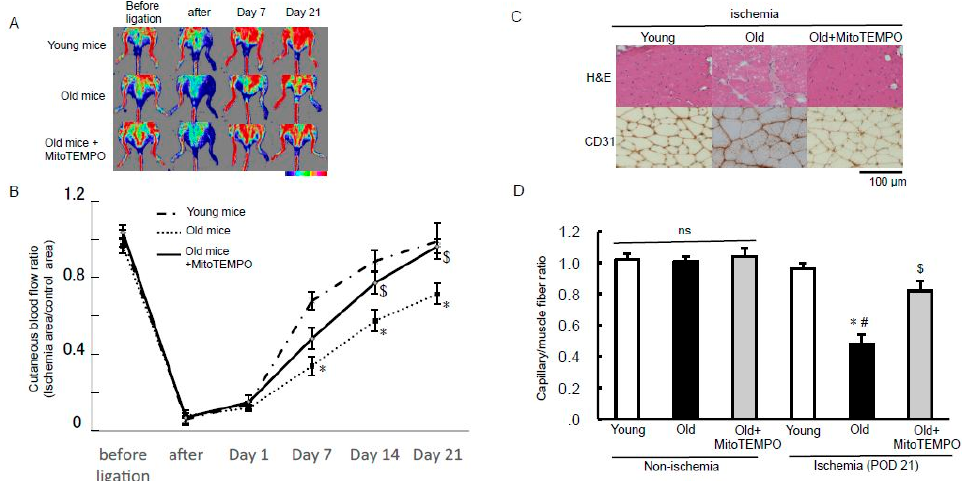
Figure 2. Effect of MitoTEMPO on age-related impairment of angiogenesis after ischemia. Representative hind limb perfusion imaging after inducing hind limb ischemia in young, old, and MitoTEMPO-treated old mice ( A ); ischemic/non-ischemic limb blood flow ratio was used for quantitative analysis ( n = 10, each. * p < 0.05 vs. young mice, $ p < 0.05 vs. old mice) ( B ); representative sections after H & E staining and immunohistochemical staining. Immunohistochemical staining was performed using anti-CD31 antibody to determine the capillary density of ischemic muscle on POD 21 ( C ); quantification of capillary density was shown as the capillary/muscle fiber ratio ( n = 10, each. * p < 0.05 vs. young mice, $ p < 0.05 vs. old mice, # p < 0.001 vs. old mice in non-ischemia) ( D ). The values are expressed as the means ± S.E.M. ns indicates no significant difference.